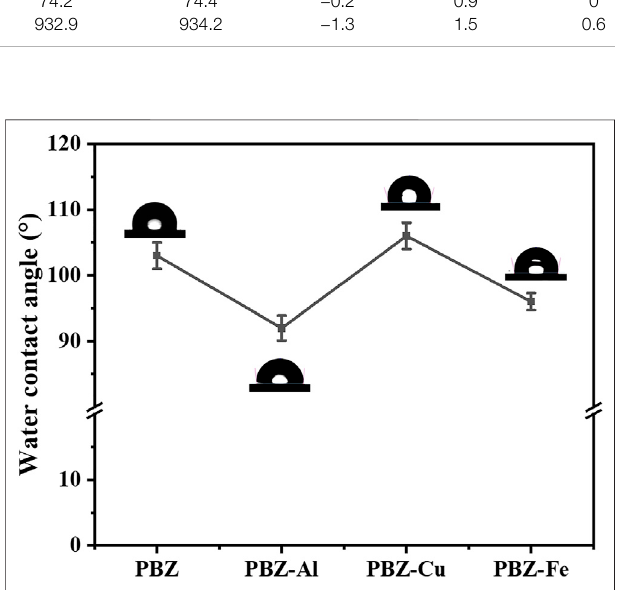
FIGURE 5 | Water contact angles of the PBZ and